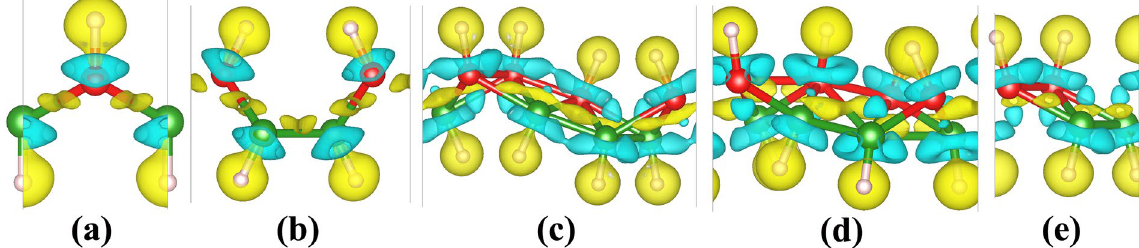
Figure 8. Deformation charge density of ( a ) C-, ( b ) B-, ( c ) TCB-, ( d ) T- and ( e ) W-borophane.